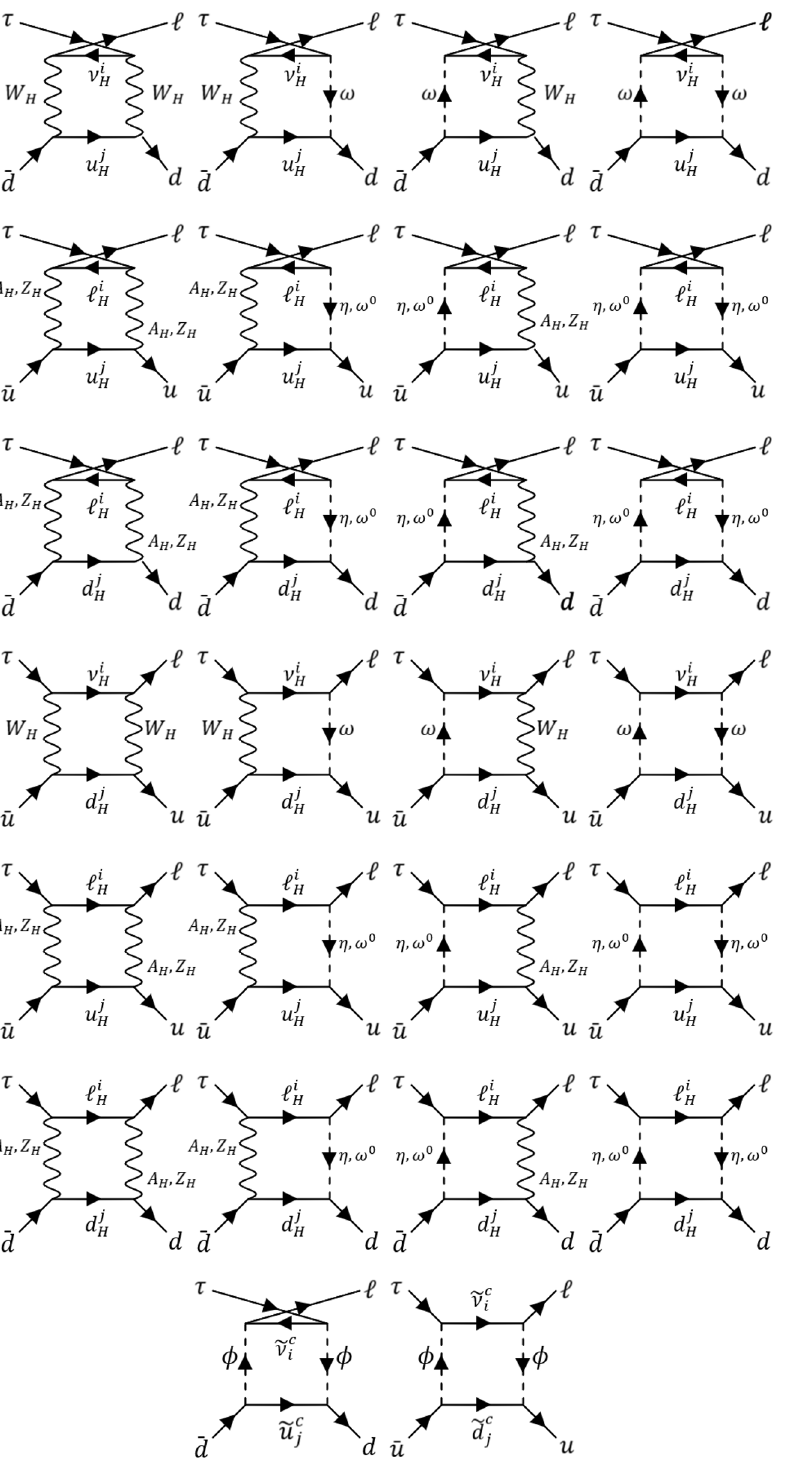
Figure 2 . Box diagrams where T-odd particles, partner leptons and quarks, are